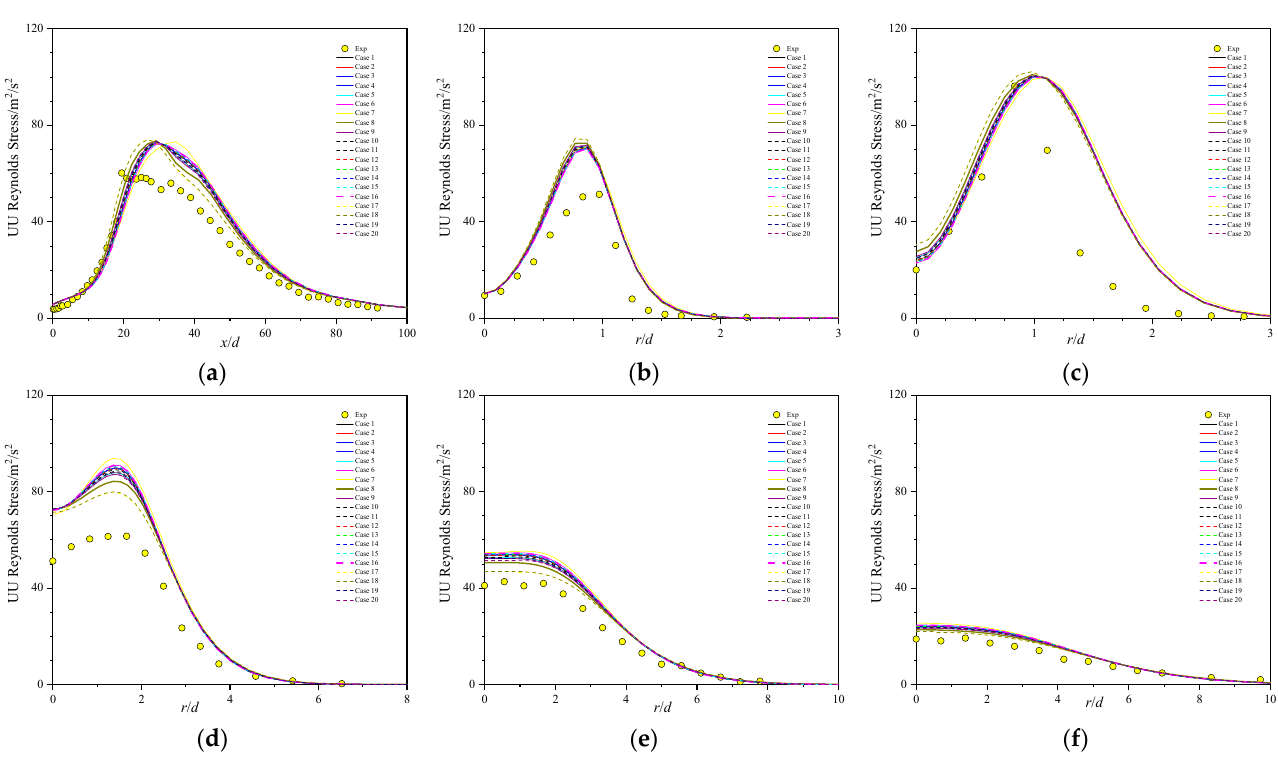
Figure 3. Comparison of measured [23,24] and predicted mean axial velocity profiles for the Sandia Flame D with 20 combinations of the primary EDC constants C D1 and C D2 . ( a ) @axis. ( b ) @ x / d = 7.5. ( c ) @ x / d = 15. ( d ) @ x / d = 30. ( e ) @ x / d = 45. ( f ) @ x / d = 60.